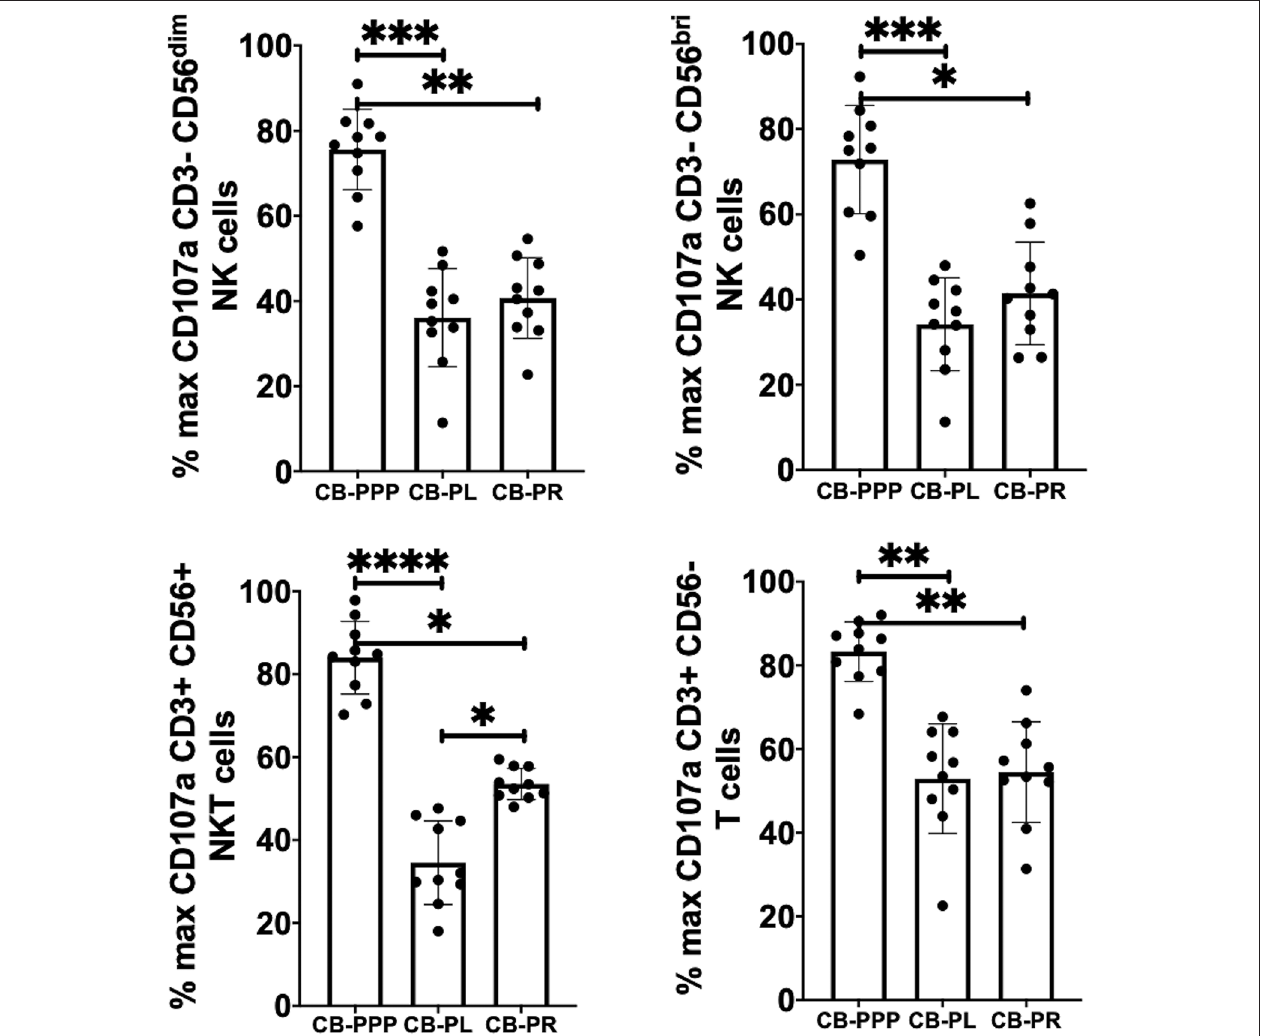
FIGURE 5 | Expression of CD107a after PMA and ionomycin stimulation on NK, NKT, and T cells from healthy donors is reduced by incubation with, CB-PPP, CB-PL, and CB-PR. Data represents analysis of CD3– CD56 dim, CD3– CD56 bright NK cells, CD3 + CD56 + NKT cells and CD3 + CD56– T cells in adult donor PBMCs ( n = 4) after incubation with CB-PRP derived samples or complete media only. Results show percentage of maximum expression relative to complete media for each cell type following 2h stimulation with PMA and ionomycin. CB-PRP preparations investigated were cord blood platelet poor plasma (CB-PPP; n = 10), cord blood platelet lysate (CB-PL; n = 10), or cord blood platelet releasate (CB-PR; n = 10). PBMCs were incubated with each preparation diluted 50:50 with media and supplemented with IL-2, or with complete media and IL-2 only for 48h prior to antibody staining and flow cytometry analysis. Each experiment was repeated with four different PBMC donors and data points represent donor means. Statistical analysis was performed using non-parametric one-way ANOVA (Kruskal-Wallis test with Dunn’s post-hoc test for unpaired samples and Friedman’s for paired samples). * p < 0.05, ** p < 0.01, *** p < 0.001, **** p <